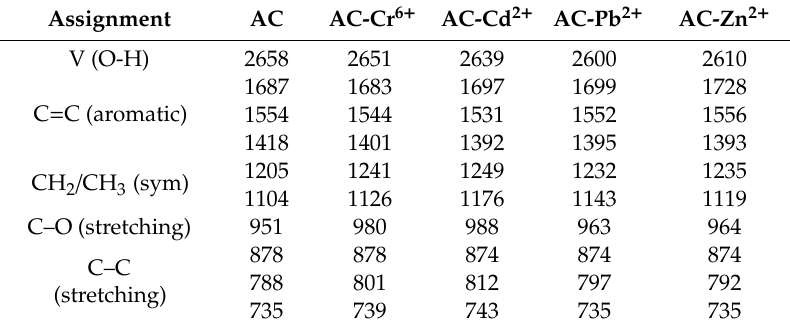
Table 1. Assignment of the infrared bands of the activated carbon before and after treatment with heavy metal-contaminated water.